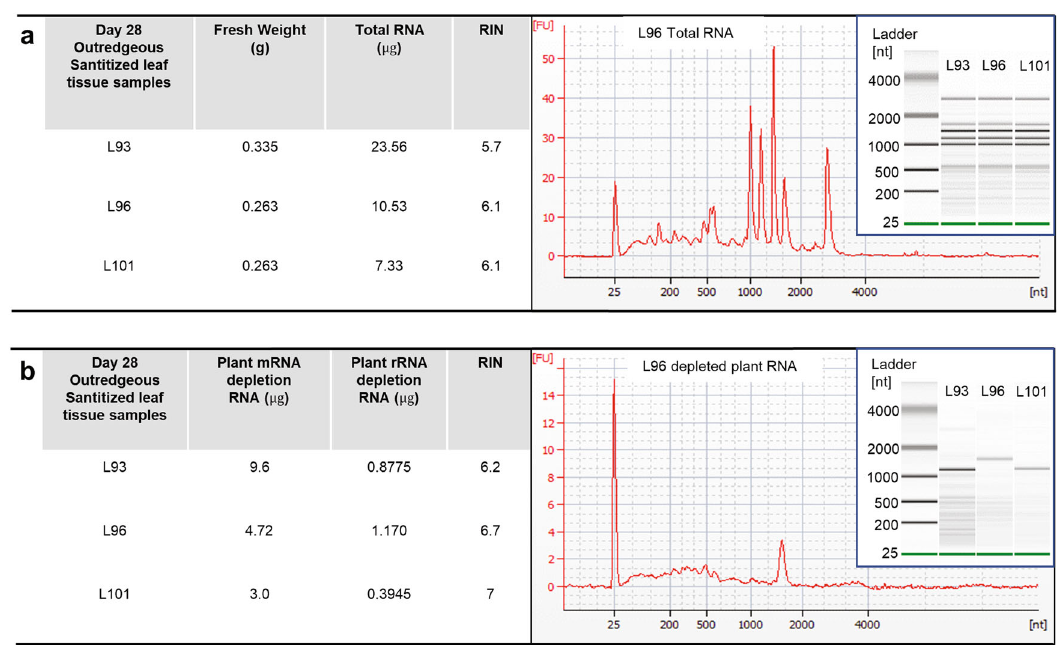
Fig. 1 Qubit and Bioanalyzer analysis for enriched microbial RNA from host – microbial total RNA. a Quality and quantity of total RNA extracted from leaves of three individual 28-day-old Outredgeous lettuce plants (L93, L96, and L101). The table shows the amount of starting material used in the RNA extraction and total host – microbial RNA extracted for each sample. Bioanalyzer results of all three samples are shown in the digital gel image and a representative electropherogram from sample L96 shows the plant rRNA peaks. b The quality and quantity of the plant-depleted RNA were assessed. Bioanalyzer results of microbial enriched RNA are shown in the digital gel image and a representative electropherogram from sample L96 shows the microbial rRNA